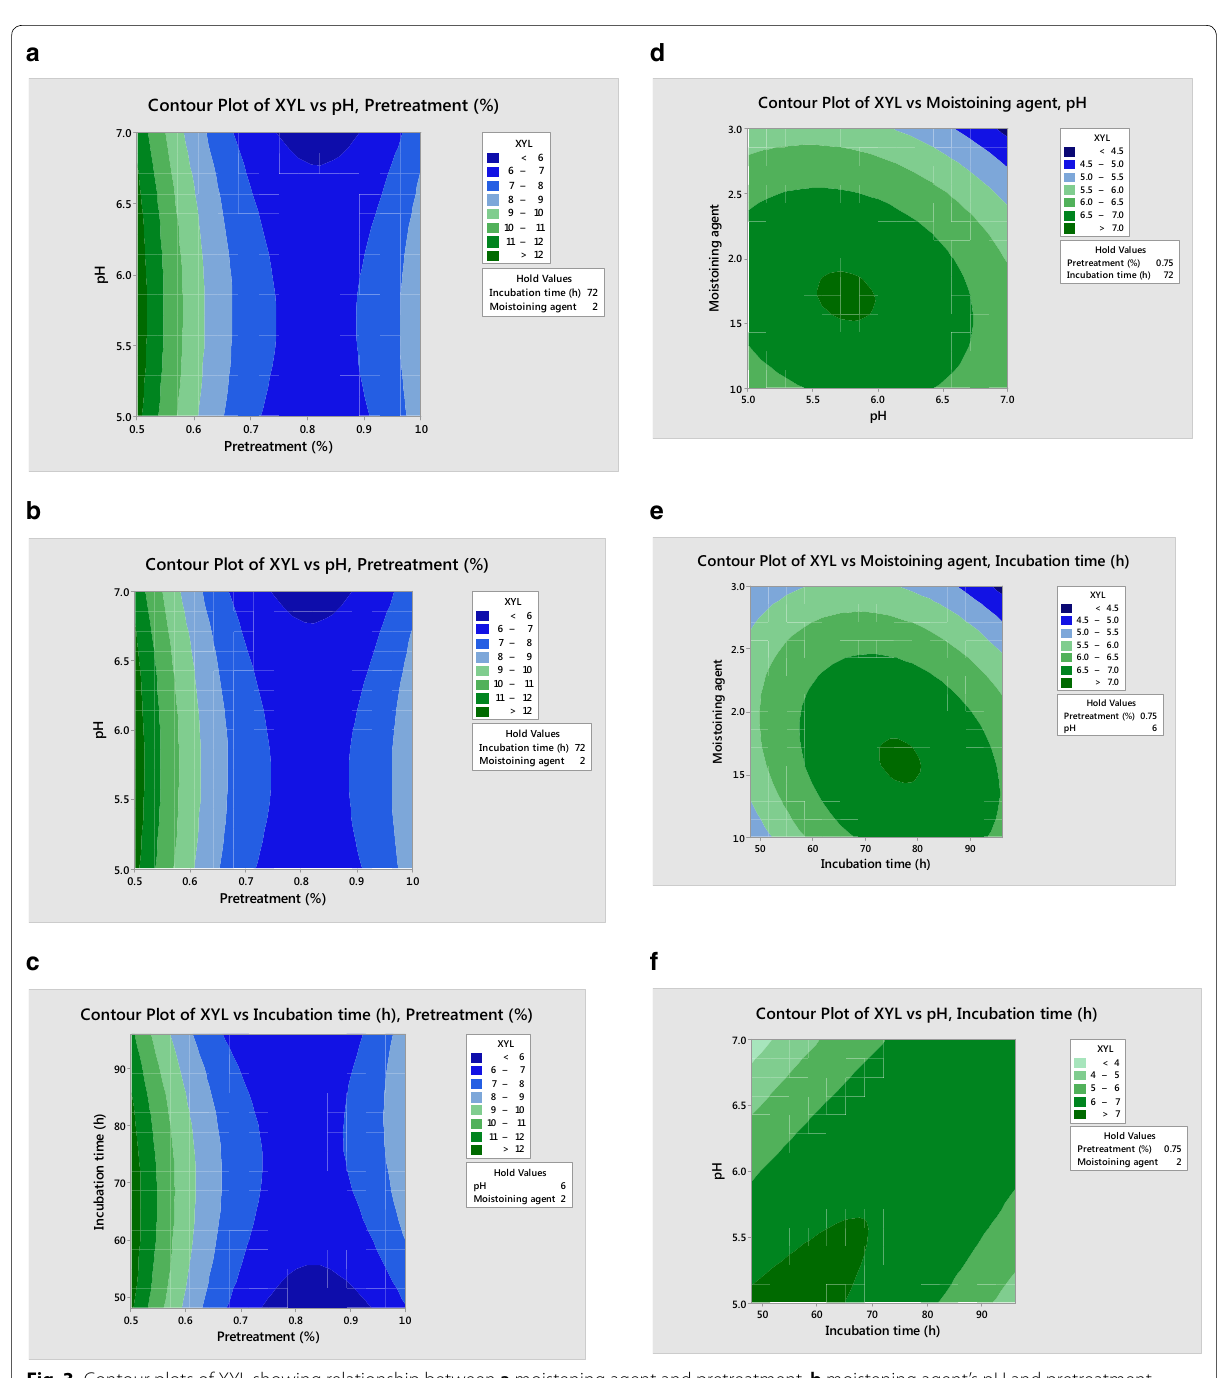
Fig. 3 Contour plots of XYL showing relationship between a moistening agent and pretreatment, b moistening agent’s pH and pretreatment, c incubation time and pretreatment, d moistening agent and its pH, e moistening agent and incubation time, and f moistening agent’s pH and incubation